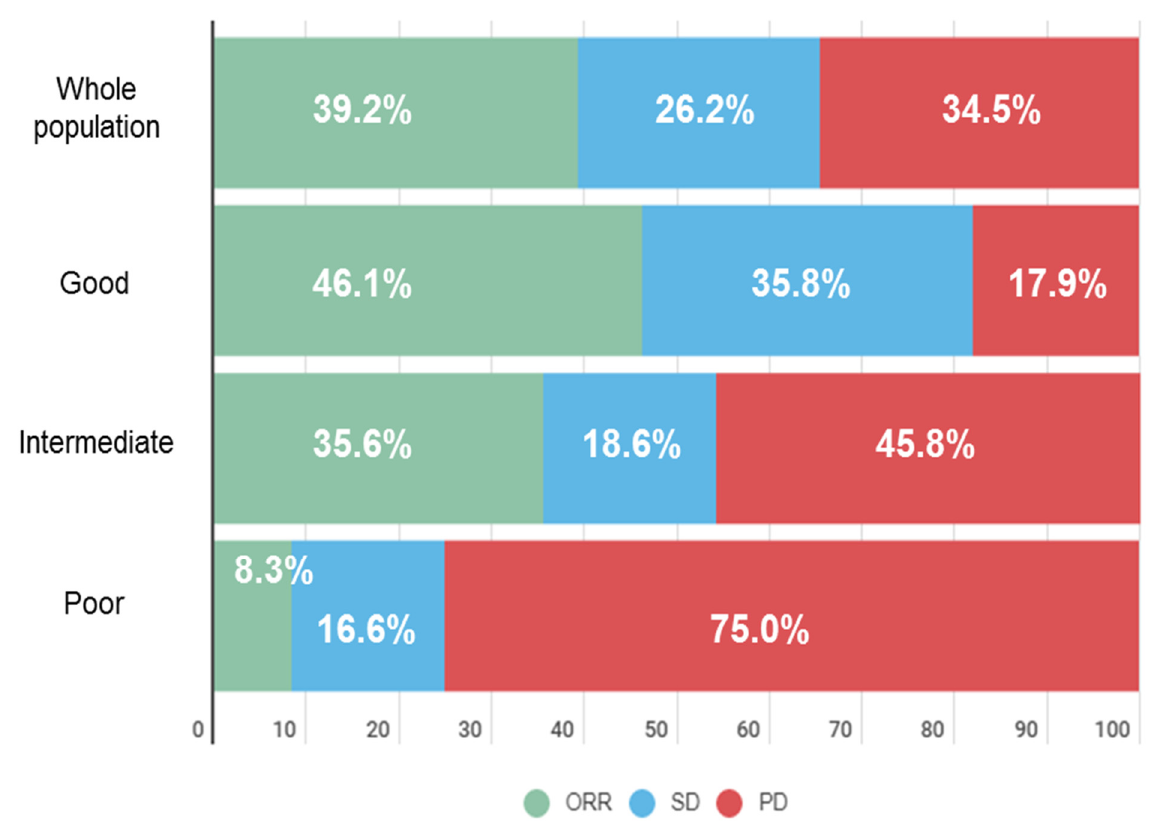
Figure 2. Best response according to LIPI group. ORR: objective response rate, SD: stable disease, PD: progression disease.